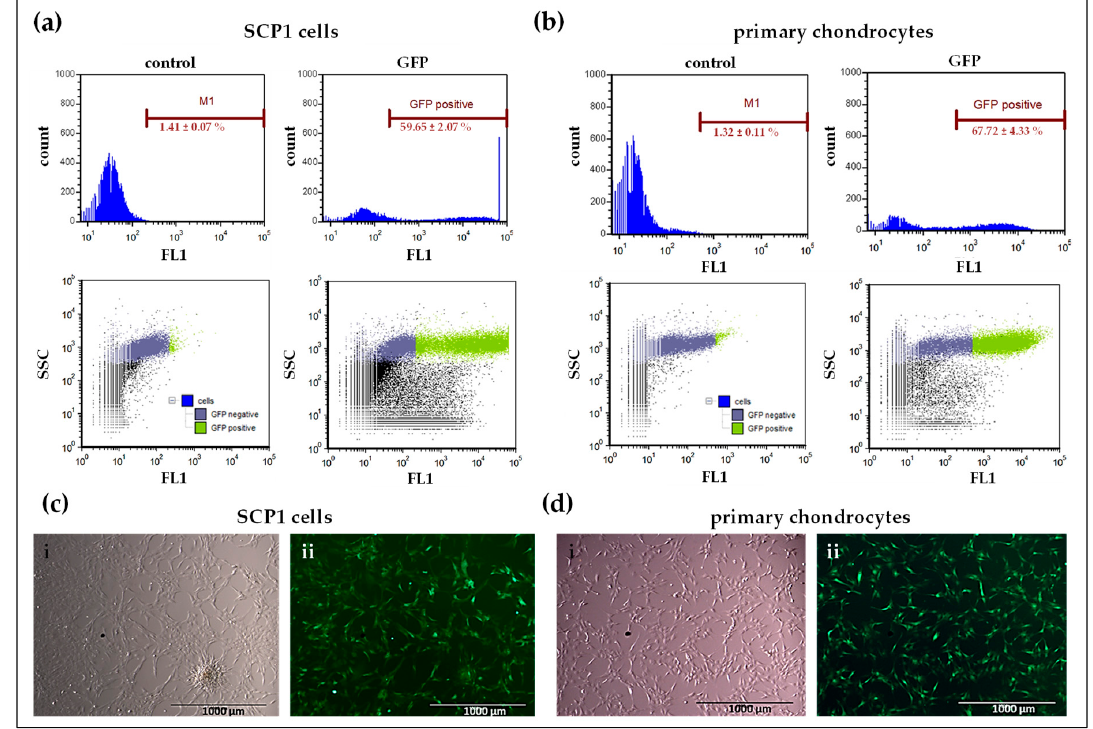
Figure 2. Analysis of transfection efficiency using eGFP mRNA in SCP1 cells and human primary chondrocytes. Flow cytometry analyses of ( a ) SCP1 cells and ( b ) human primary chondrocytes, 24 h post transfection with 1 µg eGFP mRNA using Lipofectamine 2000. Cells treated with Lipofectamine 2000 were used as controls. Representative fluorescence microscopic images of eGFP mRNA transfected ( c ) SCP1 cells and ( d ) human primary chondrocytes: (i) phase contrast bright field image; (ii) GFP channel image of eGFP mRNA transfected cells. Scale bar = 100 µm.